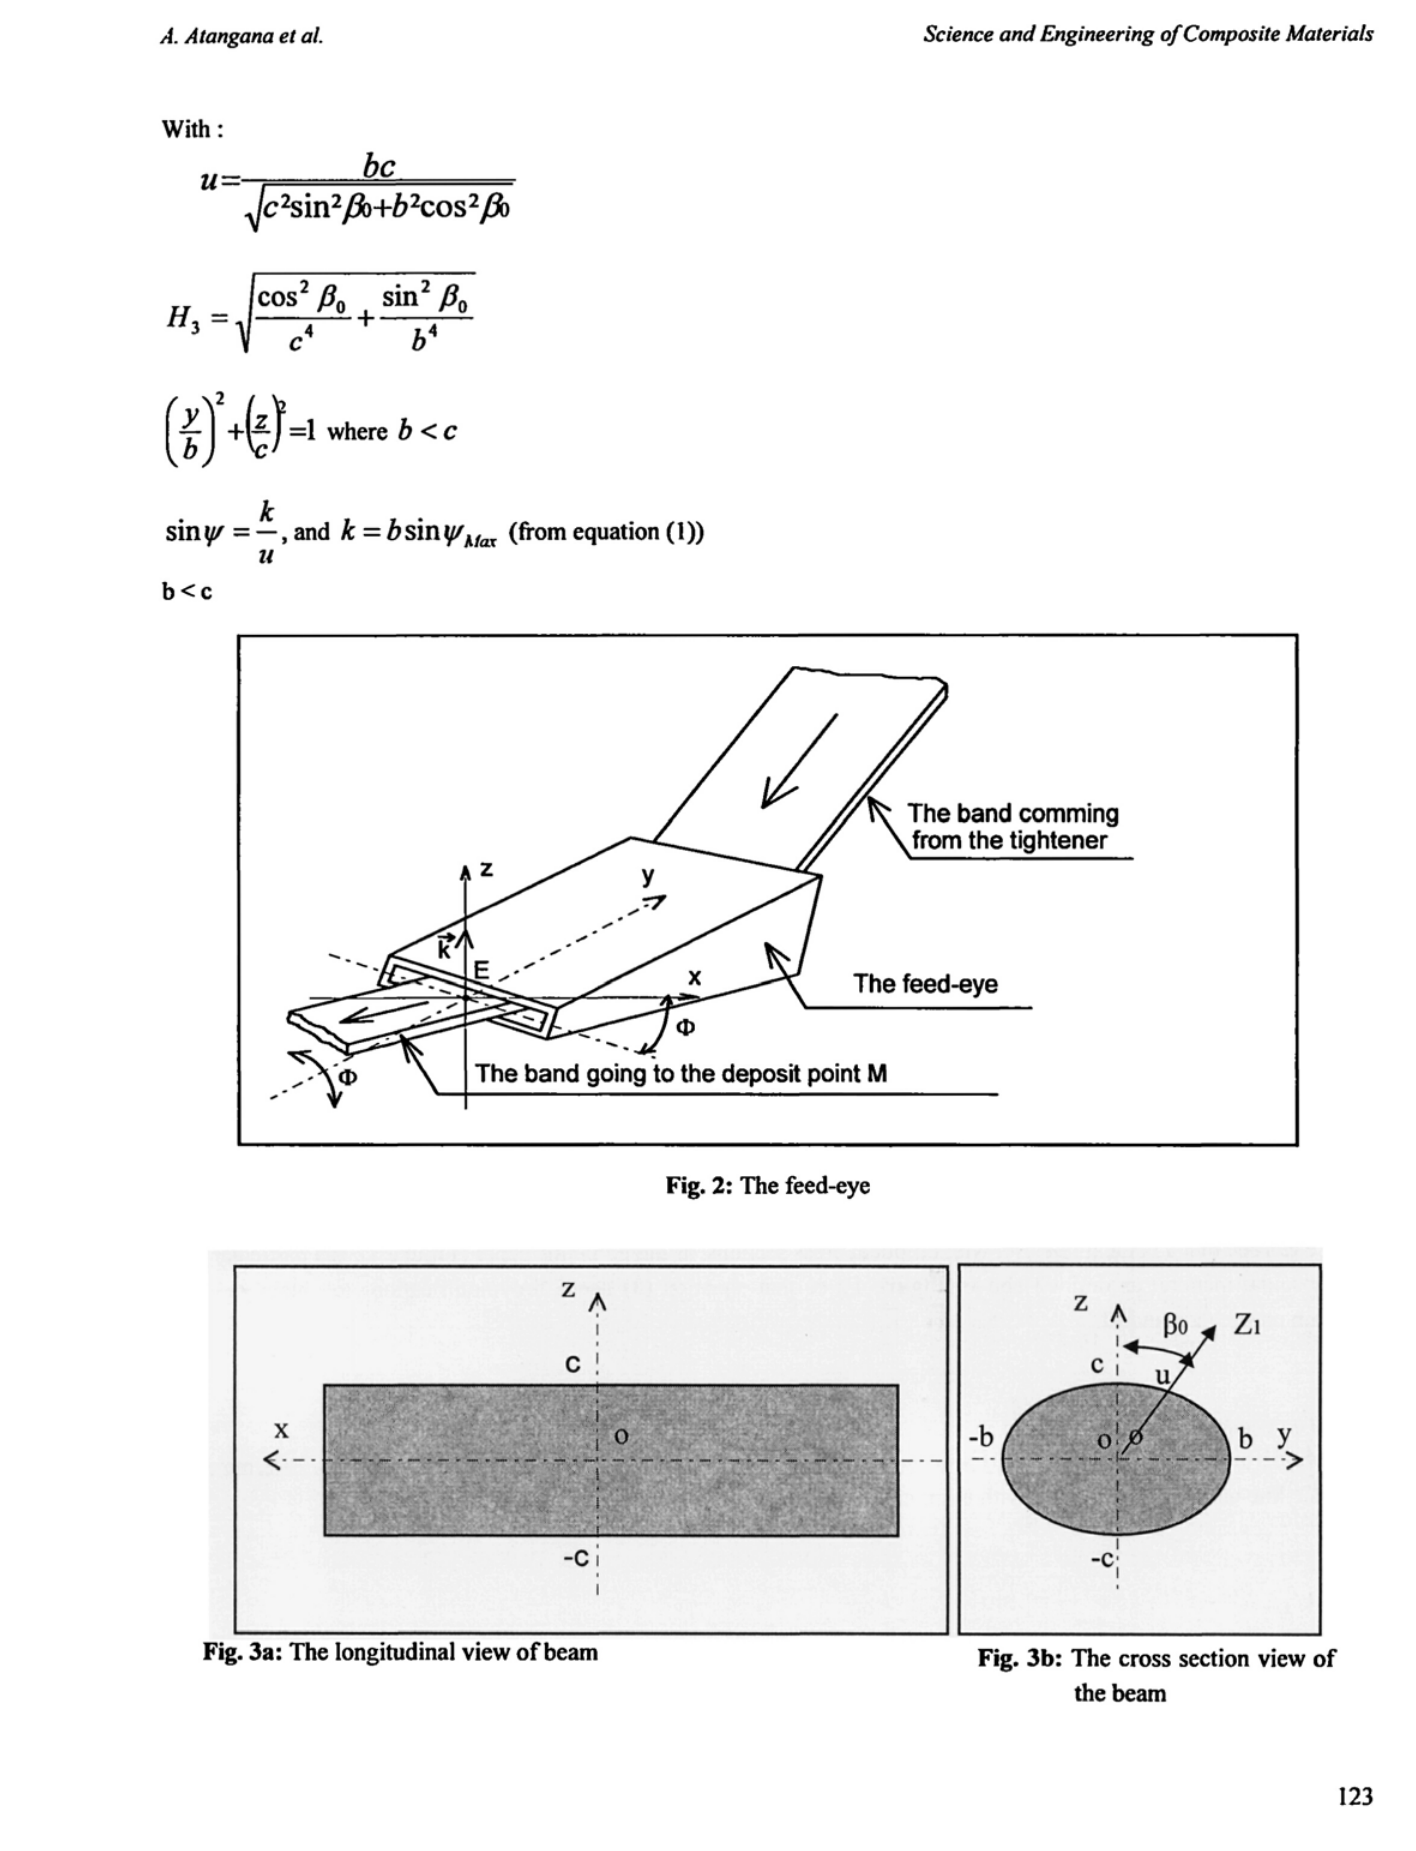
Fig. 3a: The longitudinal view of beam Fig. 3b: The cross section view